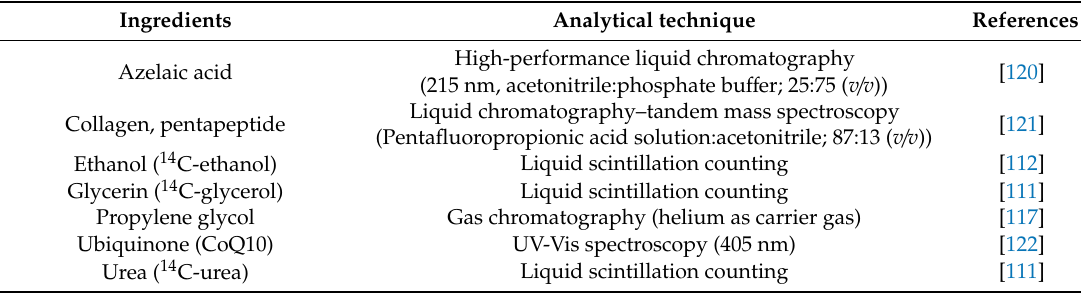
Table 6. List of methods used in the quantification of cosmetic ingredients.